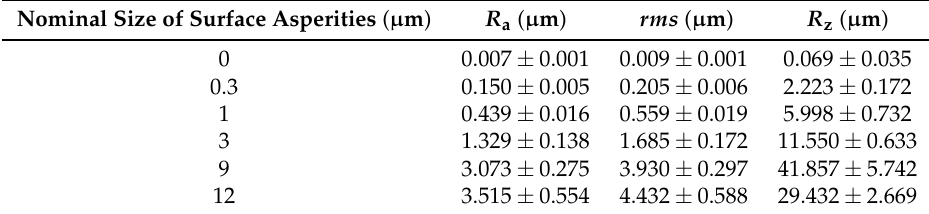
Table 1. Roughness values of tested epoxy resin